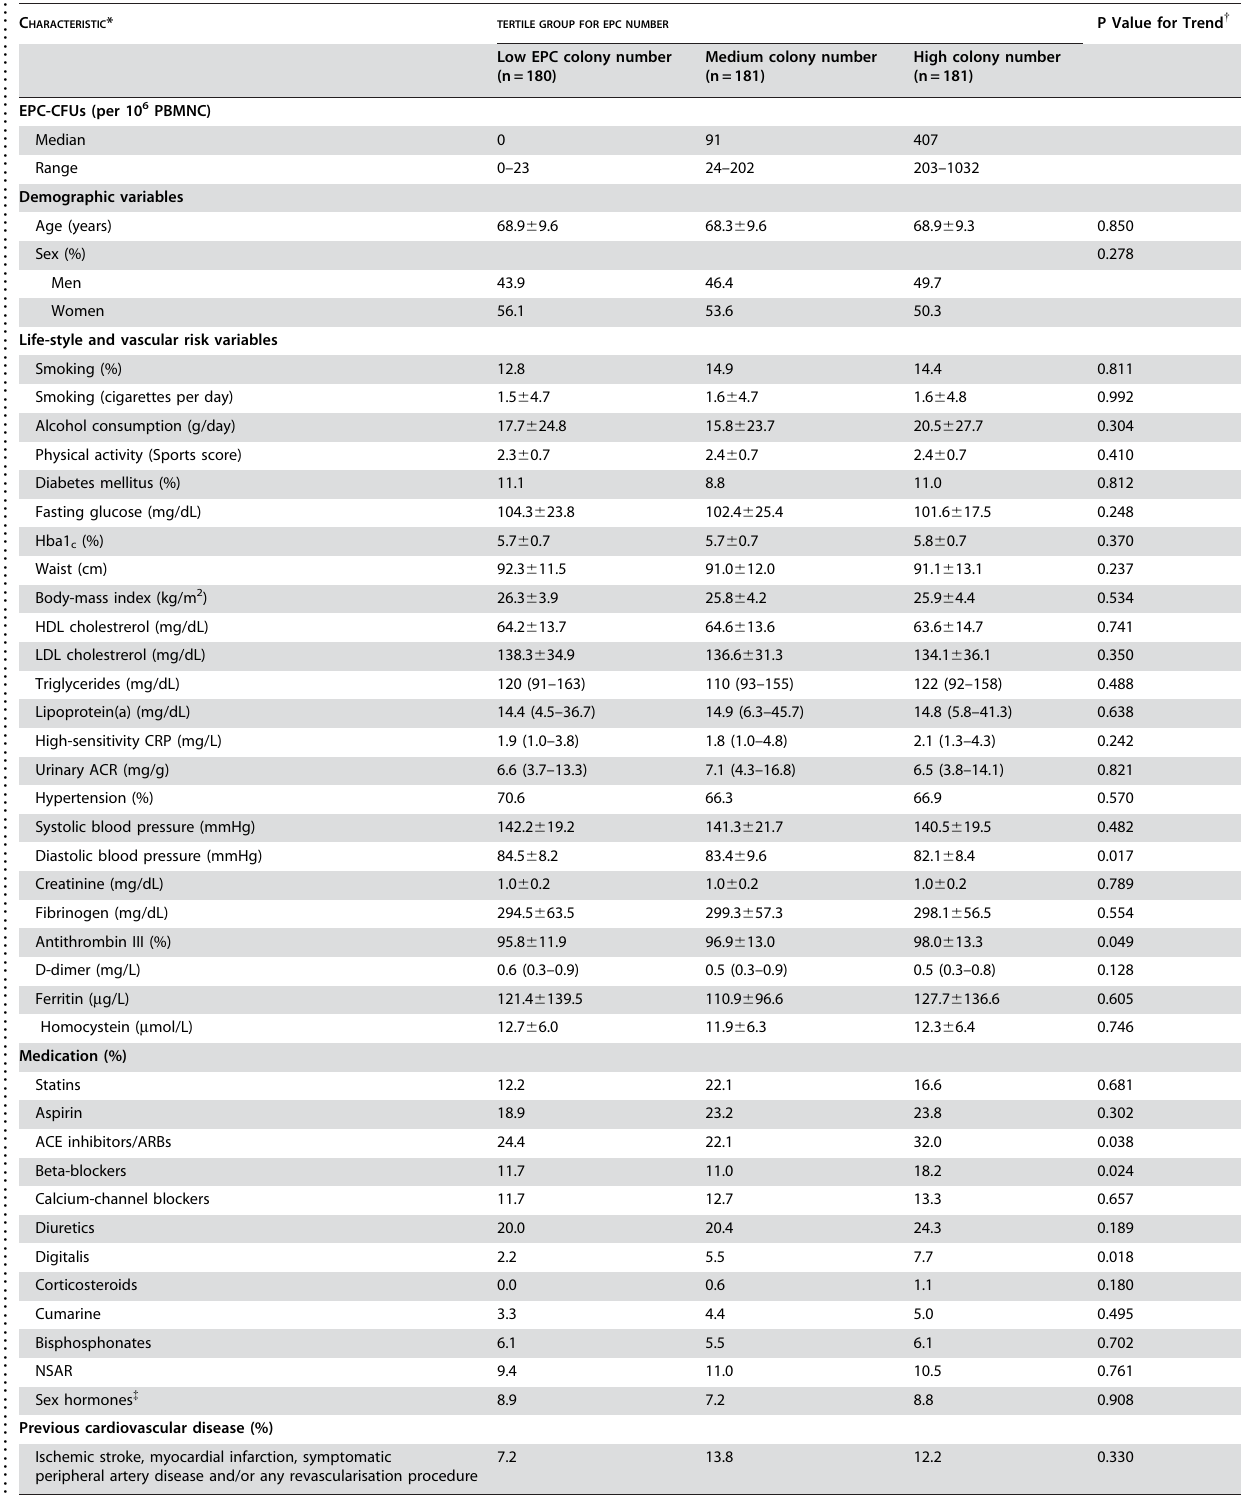
Table 2. Association of demographic and life-style characteristics, vascular risk factors, laboratory parameters and medication